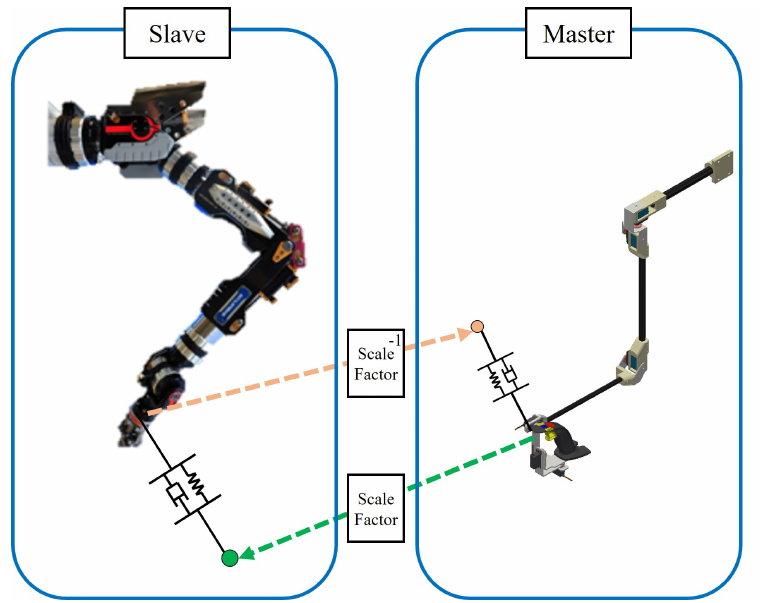
Figure 8. The bilateral teleoperation concept of